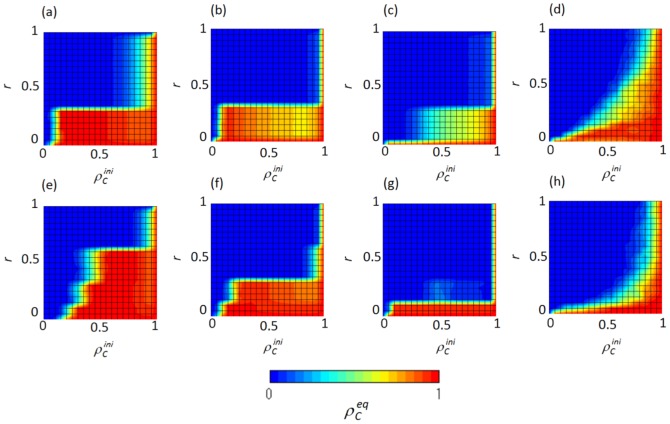
Equilibrium fraction of cooperators  on the -r parameter plane on various topologies.From left to right ((a)–(d) and (e)–(h)), the interaction networks are cycle network, square lattice network, RRG and the scale-free network, respectively. For top panel, the average degree is <k> = 4, for bottom panel it is <k> = 8.